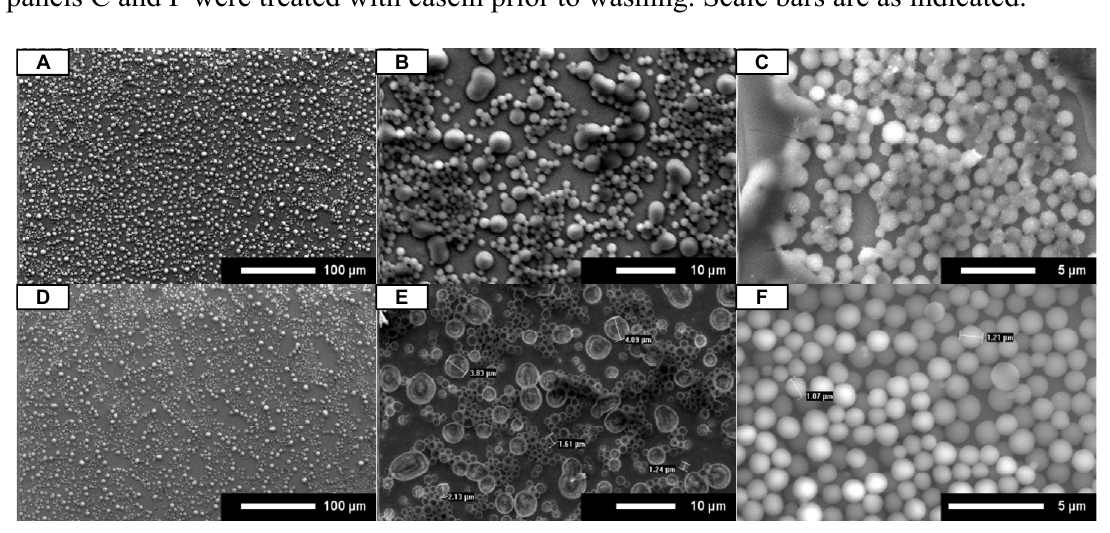
Figure 5. SEM images before (A–C) and after (D–F) washing. Coatings are B in 4:1 ethanol:water, administered by full coverage, and dried in open air. The coatings shown in panels C and F were treated with casein prior to washing. Scale bars are as